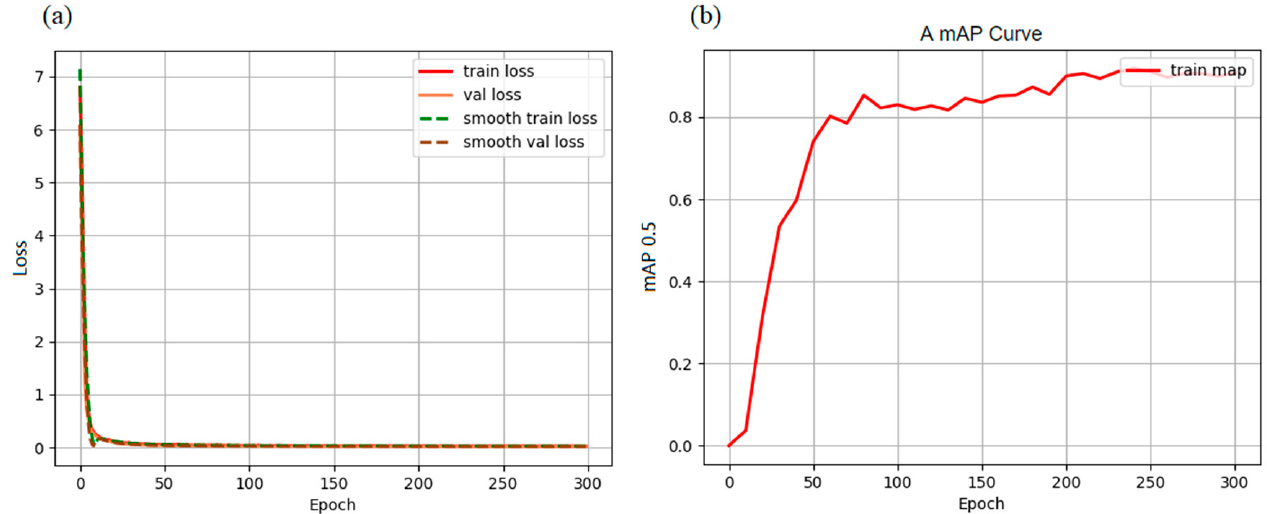
Figure 7. ( a ) Training Epoch-Loss diagram. ( b ) Training Epoch-mAP diagram.